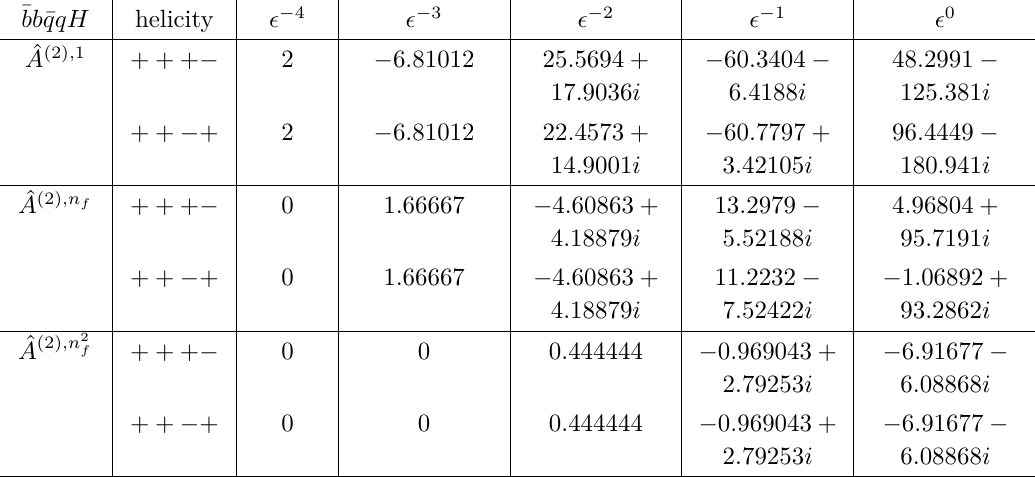
Table 4. Numerical values of the bare ¯ bb ¯ qqH partial amplitudes at two loops (normalised to the tree level amplitude) at the kinematic point in eq. (6.11) for the four independent helicity configurations and the various closed fermion loops